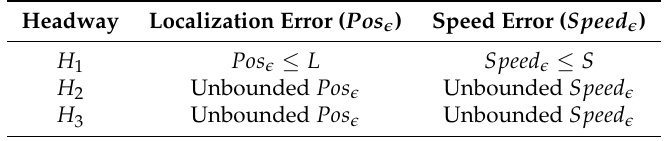
Table 1. L , S and H ( · ) are constant values known by all participants such that H 1 < H 2 < H 3 .